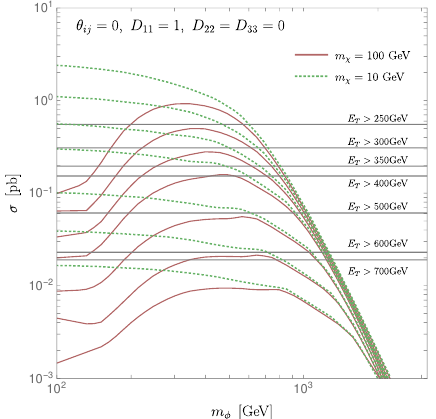
Figure 12 . Total cross section for the seven signal regions of the ATLAS monojet search [85] for two DM masses.